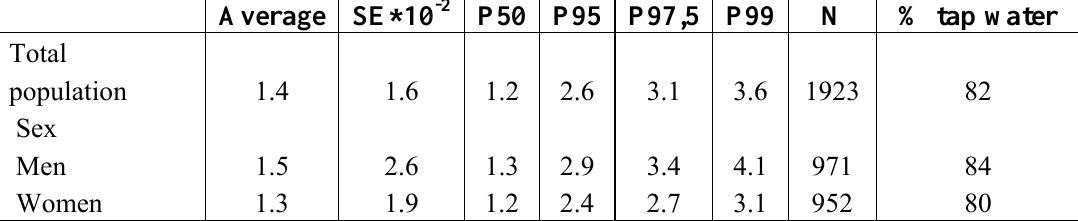
Table 3. Fluoride intake (mg/day) through consumption of non-alcoholic beverages in Flanders, by sex and age group (Food Consumption Survey,